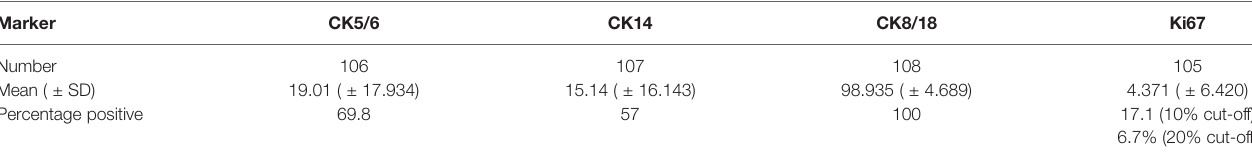
TABLE 3 | Luminal and basal cytokeratins and Ki67 expression in gynaecomastia lesions. Marker